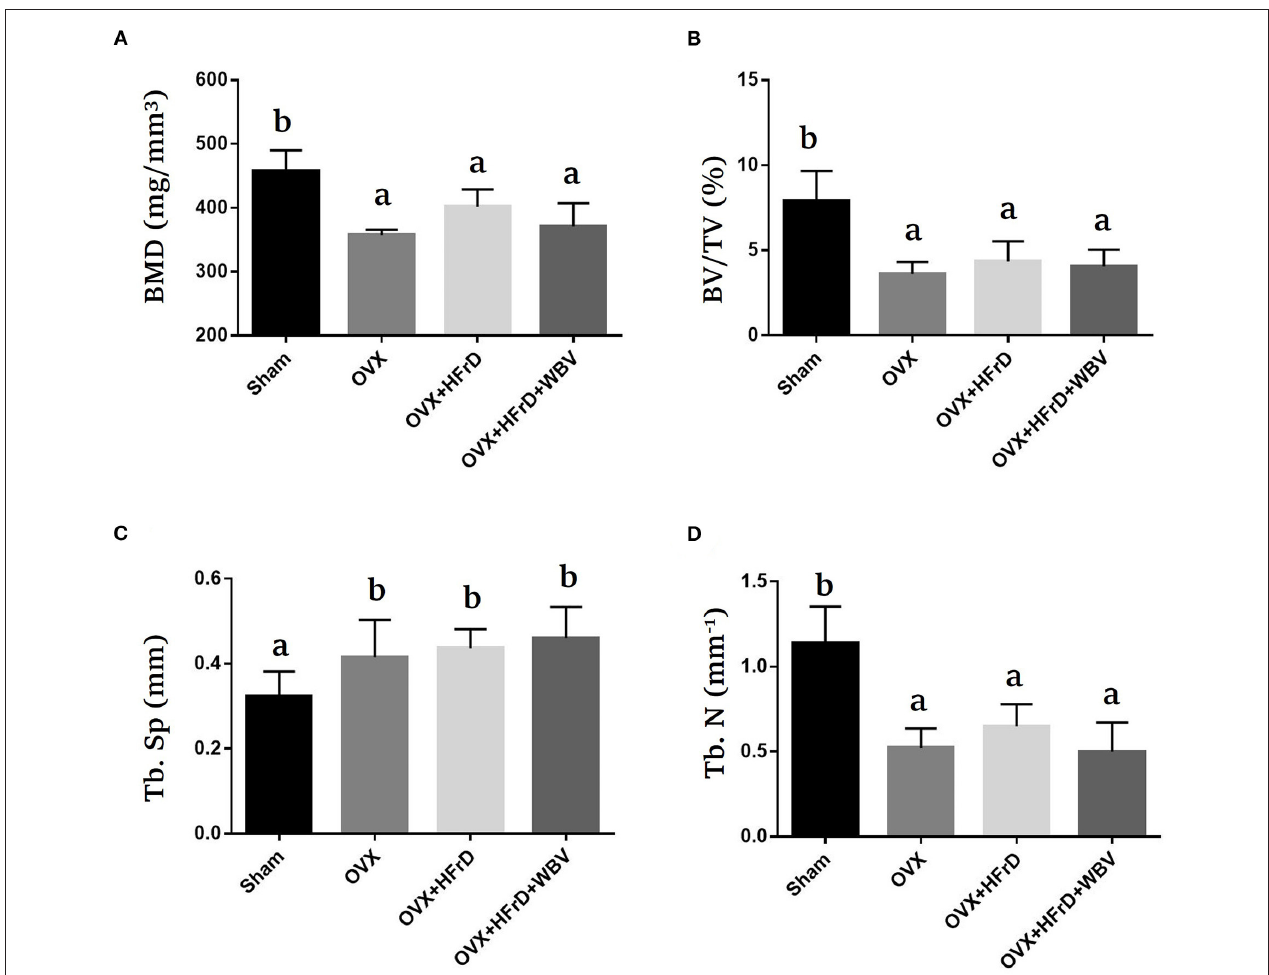
FIGURE 7 | The effects of whole-body vibration (WBV) combined with a high-fructose diet (HFrD) on ovariectomized (OVX) mice in terms of osteoporosis. The femurs of the mice were individually collected and subjected to micro-CT analysis for bone mineral density (BMD) (A) , bone volume fraction (BV/TV) (B) , trabecular separation (Tb.Sp) (C) , and trabecular number (Tb.N) (D) . The data are presented as means ± SD. Different superscript letters indicate significant differences ( P < 0.05), as indicated by a one-way analysis of